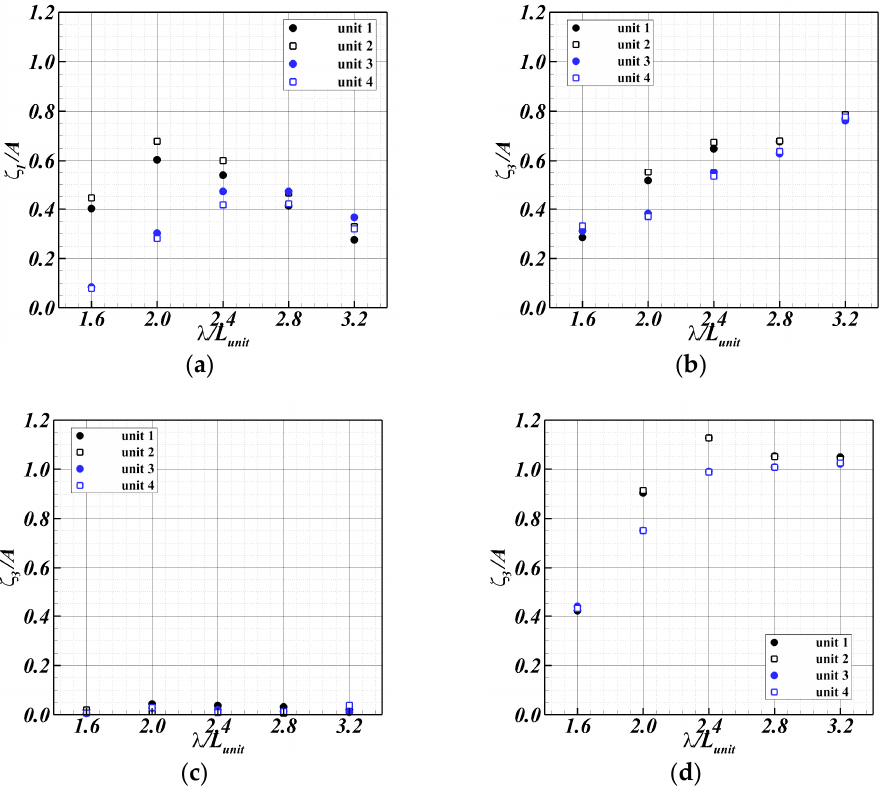
Figure 14. Motion RAOs of the experiment according to the wavelength at 𝑯/𝝀 = 0.03: ( a ) surge; ( b ) heave; ( c ) roll; ( d ) pitch.